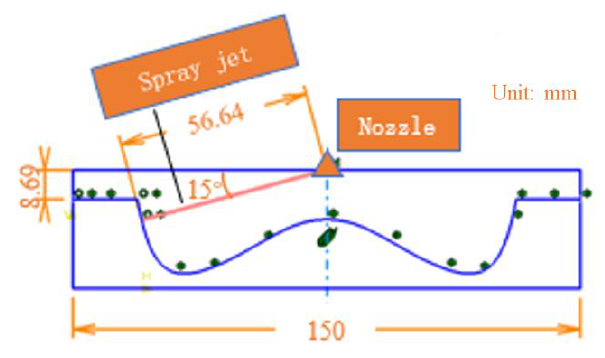
Figure 6. Determination of impinging distance.